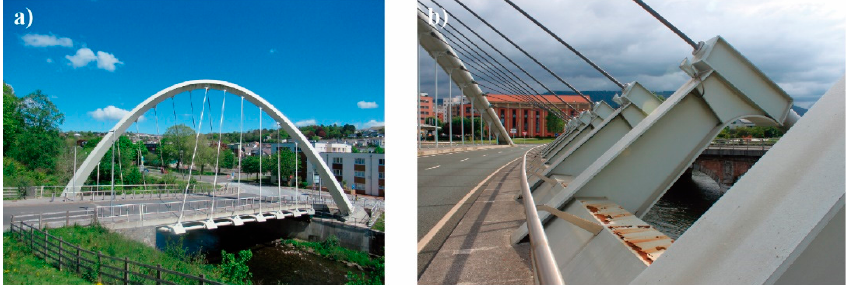
Figure 26. ( a ) River Taff Central Link Bridge (14a) (photo, Alex Liivet, flickr) and ( b ) detail of inclined stiff elements protruding from the deck, Arch Bridge over the Galindo river (photo, Juan Manuel Garc í a-Guerrero).